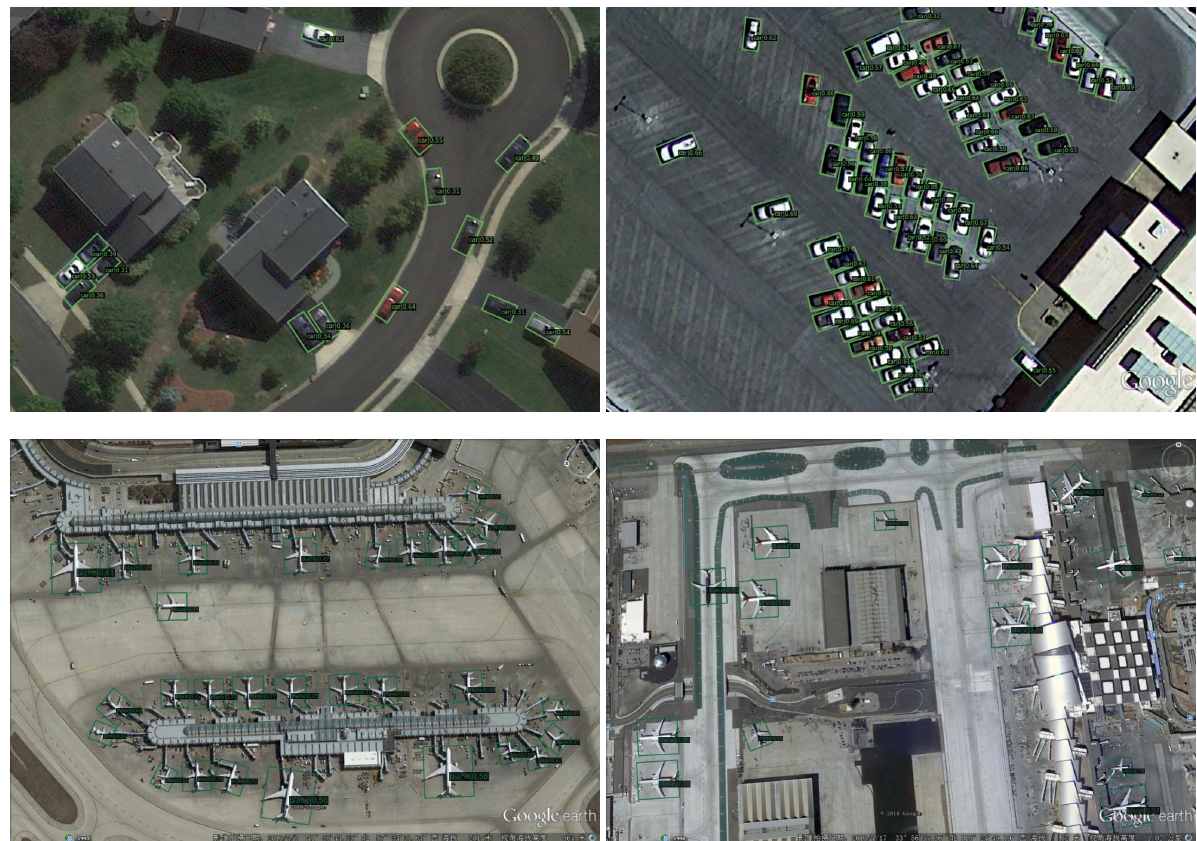
Figure 10. Visualization of predictions on the UCAS-AOD dataset using our